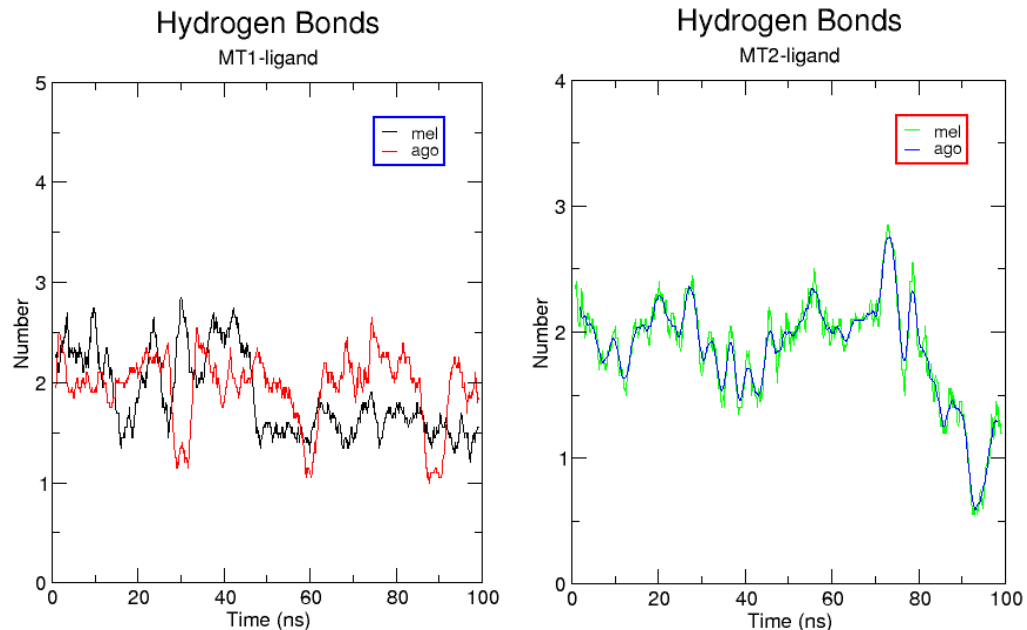
Figure 8. H-bonding interaction evolution along the 100 ns MD trajectory.